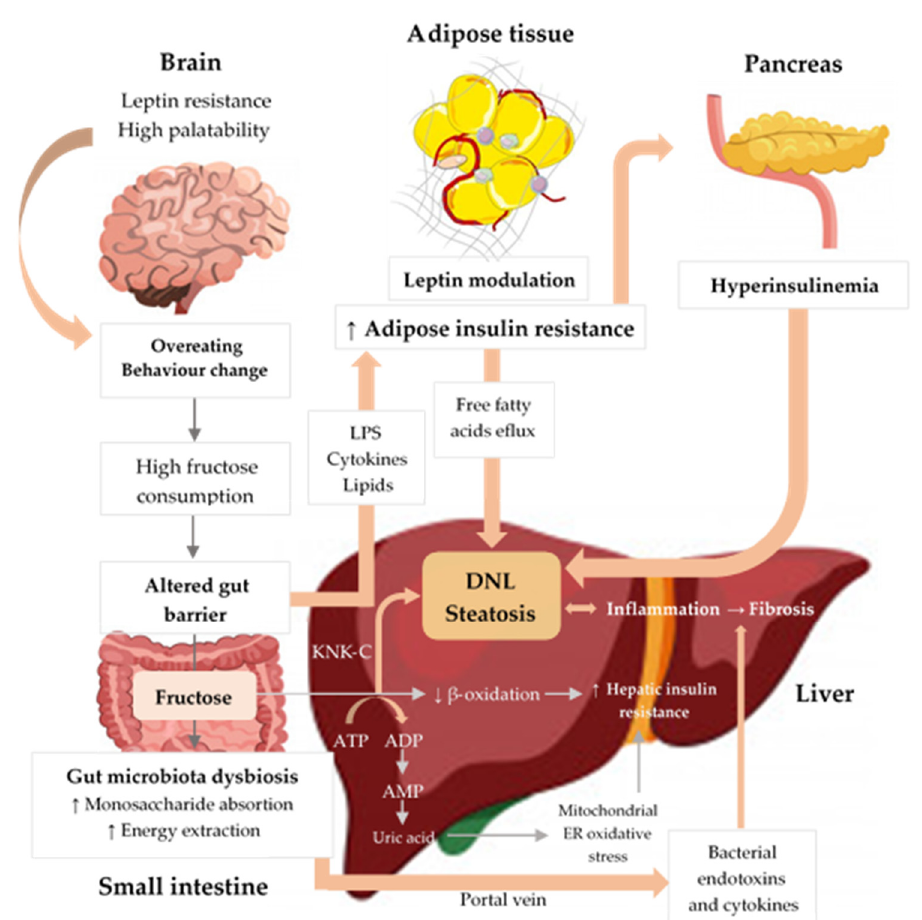
Figure 2. Excessive fructose intake is associated with inflammation, cellular stress, dysbiosis, and hepatic steatosis. Fructose strongly activates DNL, inducing IR and liver inflammation. Fructose metabolism by fructokinase (KHK–C) leads to uric acid generation, mitochondrial dysfunction, and oxidative stress, which contributes to hepatic IR and inflammation. Additionally, high fructose consumption induces gut microbiota dysbiosis, which increases gut permeability, leading to translocation of bacterial endotoxins, cytokines, and lipopolysaccharide (LPS), thus driving hepatic inflammation and IR. Finally, fructose increases peripheral IR through LPS, cytokines, and lipid oxidation and negatively influences appetite through gut–brain axis alterations, high palatability, and leptin modulation, thereby promoting increased energy intake and weight gain [95–99]. Upwards pointing arrows ( ↑ ) indicate increase, downwards pointing arrows ( ↓ ) indicate decrease.